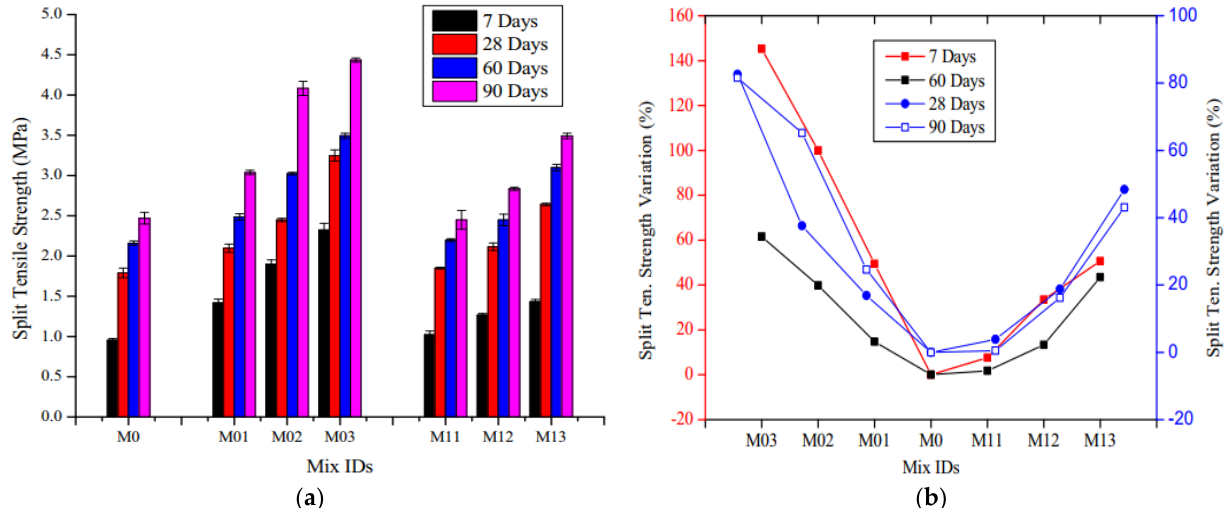
Figure 10. ( a ) STS of concrete at different ages [124]; ( b ) percentage variation in the STS of concrete at different ages [124]. The mixes M0, M01, M02 and M03 represent self-consolidating concretes with MSF contents of 0, 0.5, 1.0 and 1.5 %, respectively. The mixes M11, M12 and M13 represent self-consolidating concrete with WRSF contents of 0.5, 1.0 and 1.5 %, respectively.